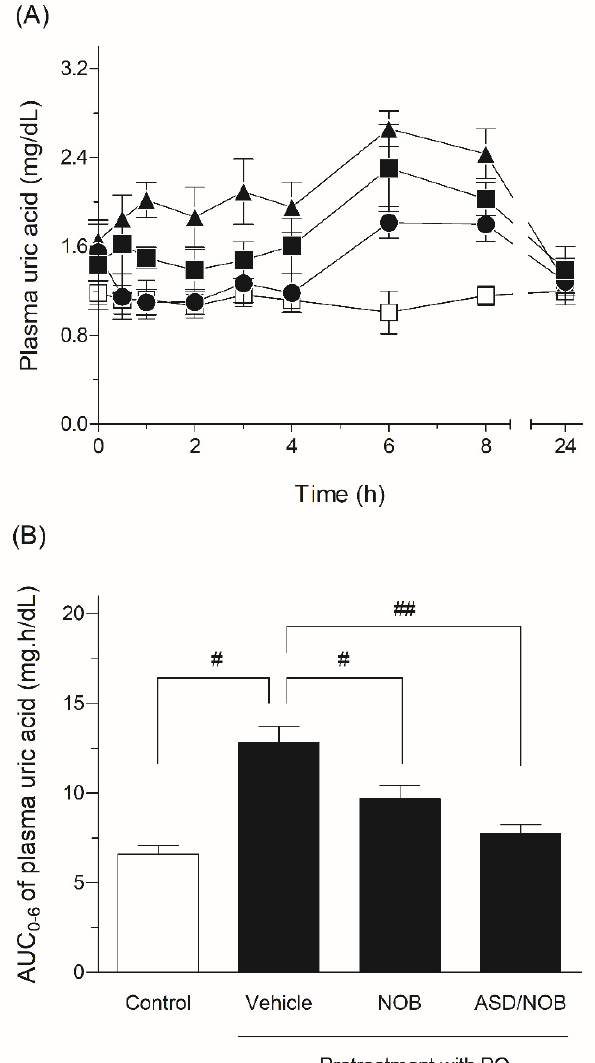
Figure 5. Pharmacodynamic behavior in a rat model of hyperuricemia induced by PO. ( A ) Plasma uric acid level-time profiles in rats after the oral administration of NOB samples. □ , Control; ▲ , PO (250 mg/kg, i.p.); ■ , PO with orally-dosed crystalline NOB (50 mg/kg); ● , PO with orally administered ASD/NOB (50 mg NOB/kg). ( B ) AUC 0–6 values of plasma uric acid in rats with orally administered NOB samples. # , p ≤ 0.05 and ## , p ≤ 0.01 between indicated loops. Data represent the mean ± SE of six experiments.